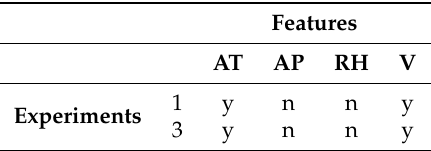
Table 7. Variable selection results in each experiment. Those selected features are represented with y (yes), the rest with n (no).